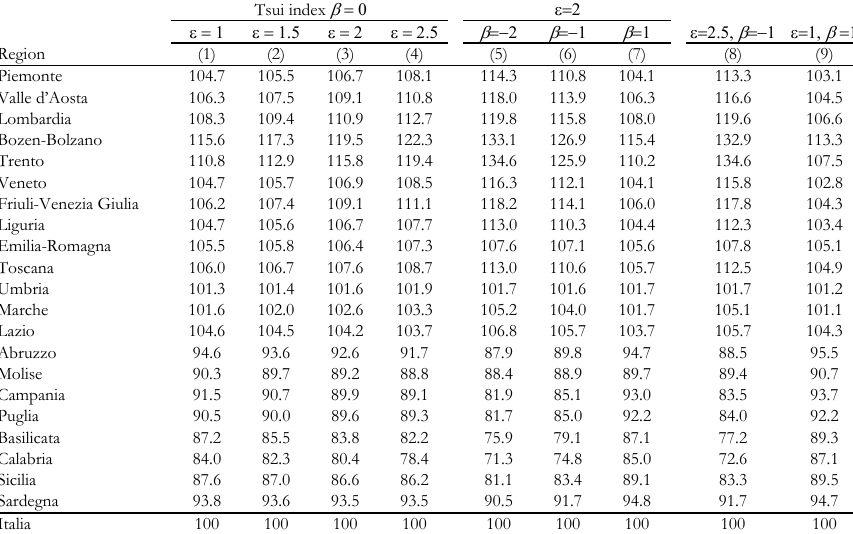
Regional multidimensional well-being measures (year